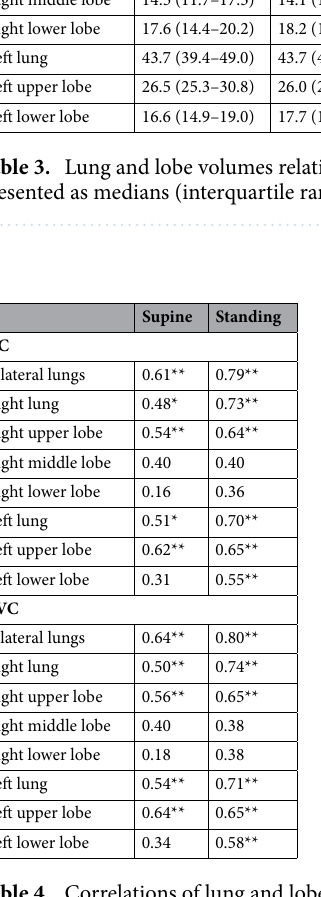
Table 4. Correlations of lung and lobe volumes in the supine and standing positions from the PFT. PFT pulmonary function test, VC vital capacity, FVC forced vital capacity. * and ** indicate p < 0.05 and p < 0.01,